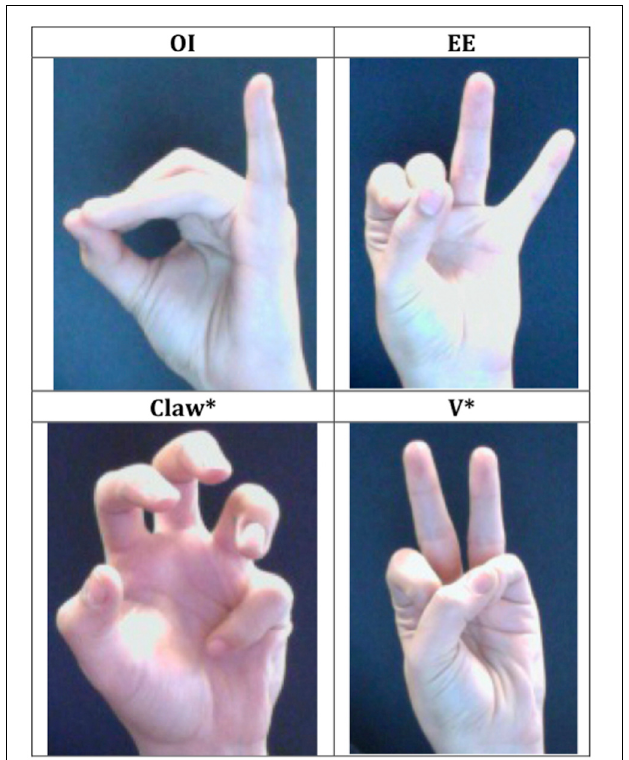
FIGURE 4 | An illustration of the four unattested handshapes used in Experiments 3–4.